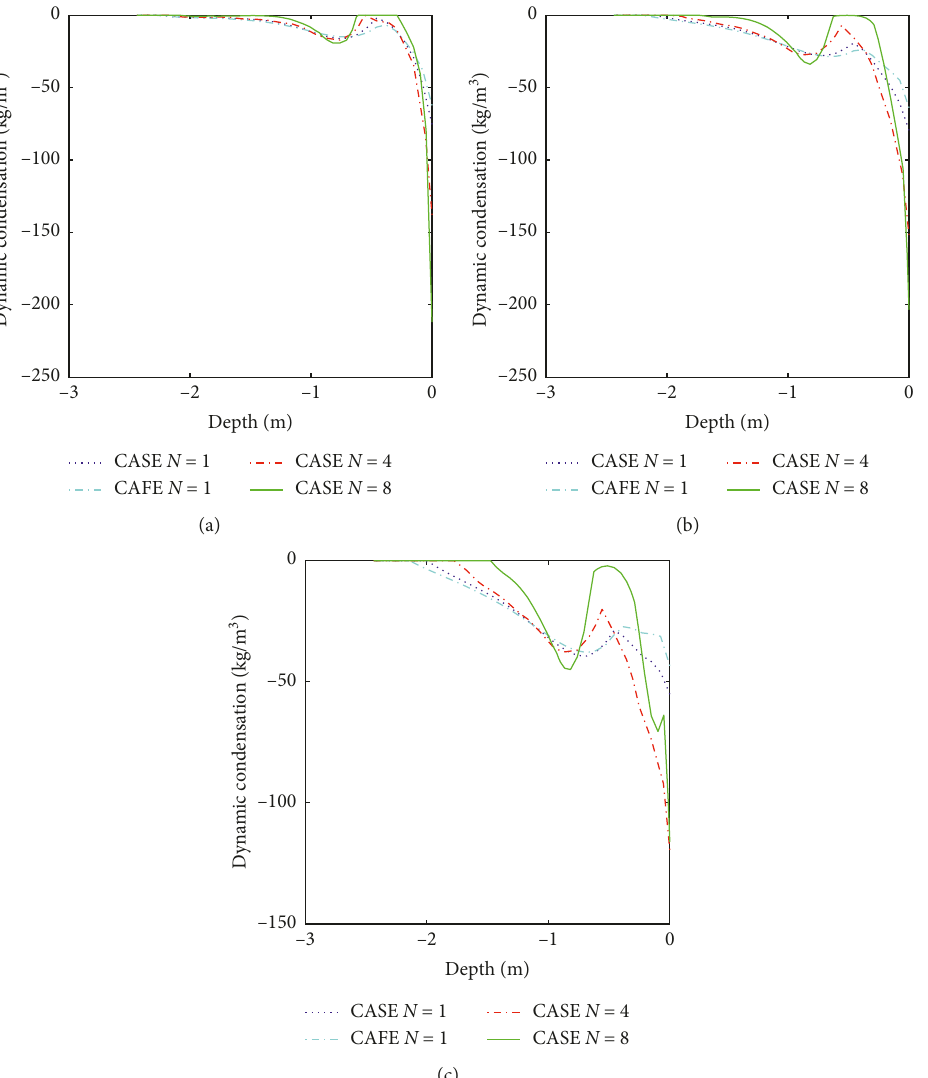
Figure 14: Dynamic condensation distribution at (a) 10ms, (b) 20ms, and (c)